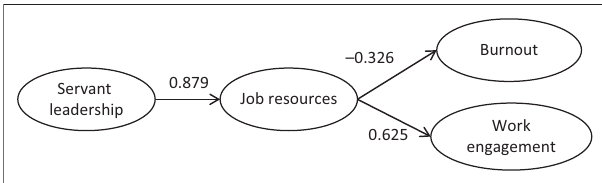
FIGURE 1: Research model with findings